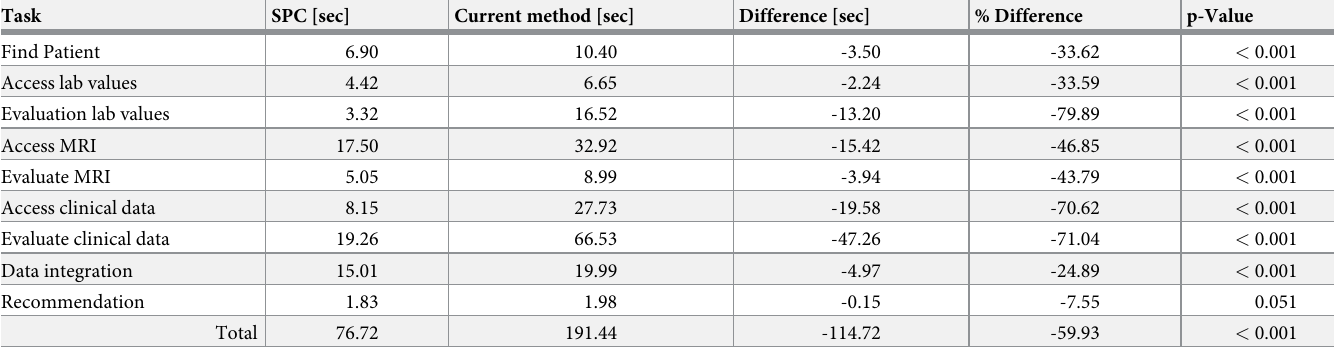
Table 2. Mean and standard deviation values for total case evaluation times the software vs current method as a function of user.